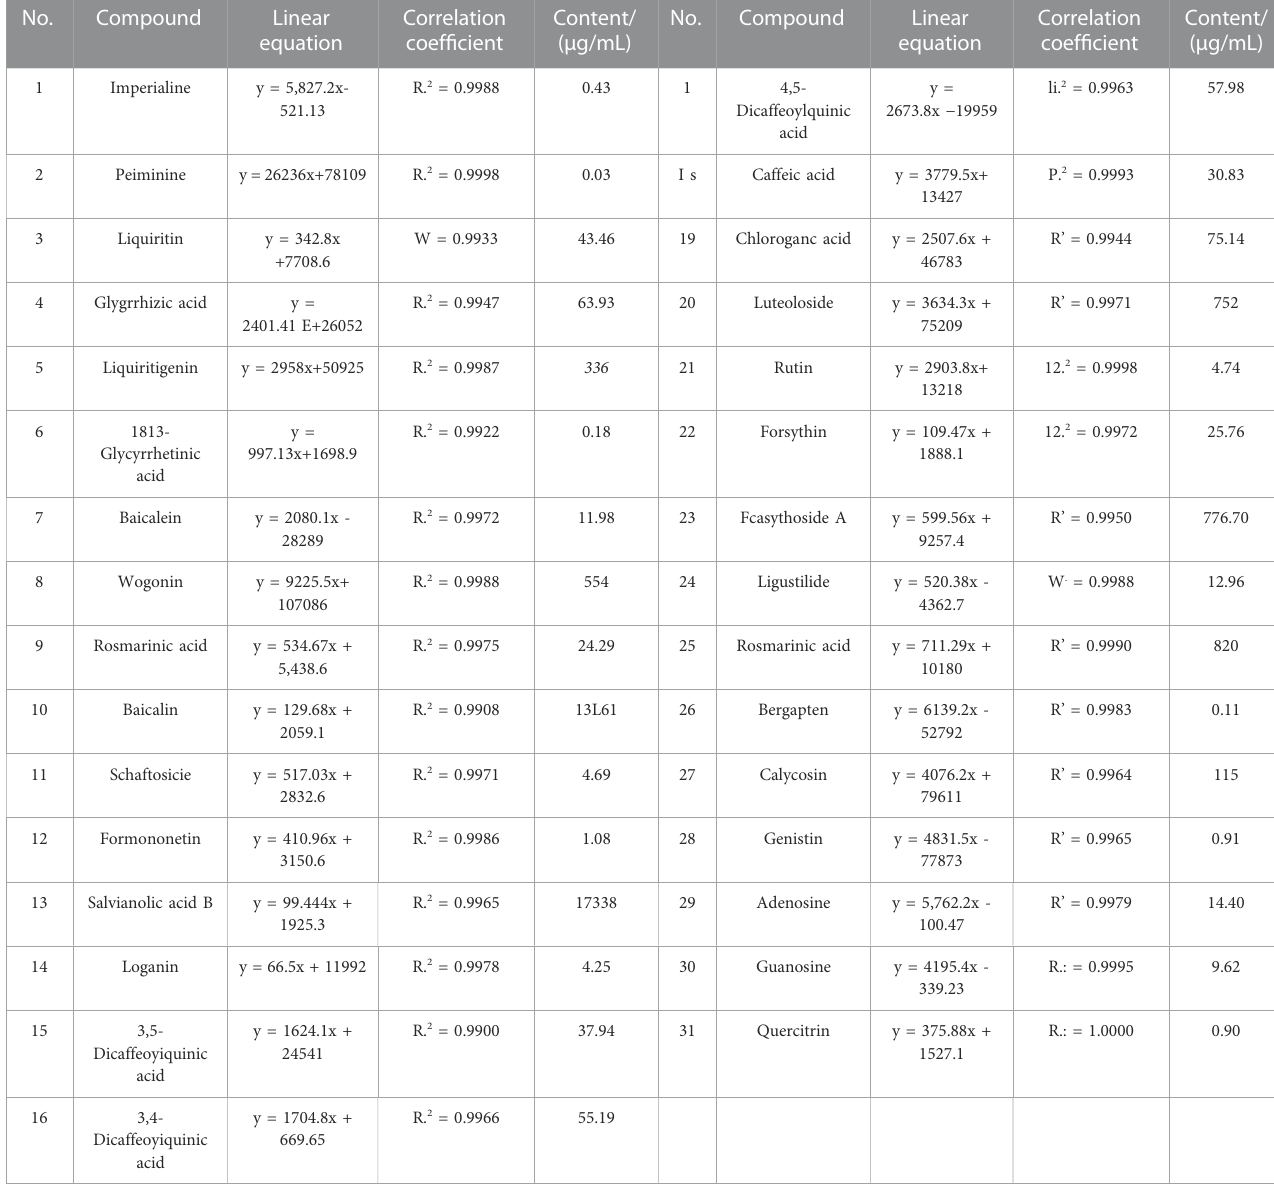
TABLE 2 Calibration curves and determination of 31 compounds detected in Jinbei oral liquid.